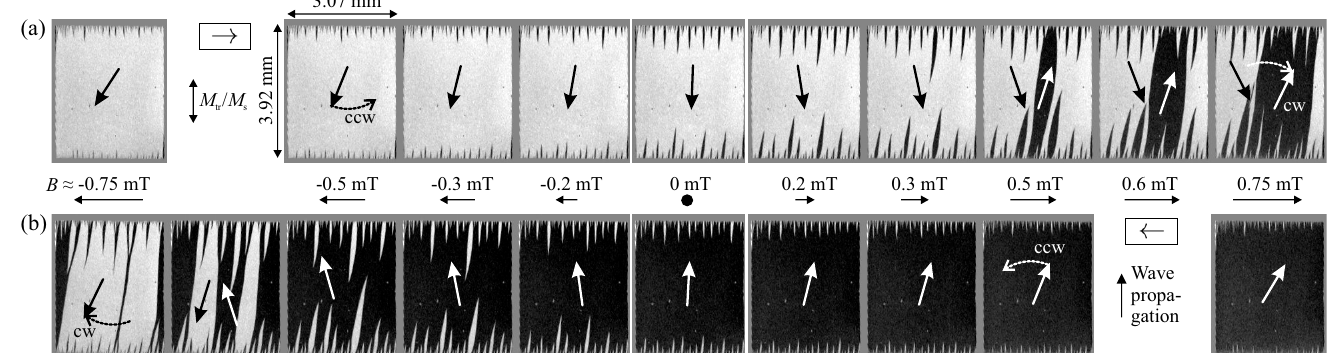
Figure 3. Magnetic domain evolution for increasing ( a , → ) and decreasing ( b , ← ) direction of external field B . Magnetic field values are indicated. The corresponding basic alignment of magnetization inside the magnetic film is sketched. The magnetooptical sensitivity is transverse to the applied magnetic field direction.